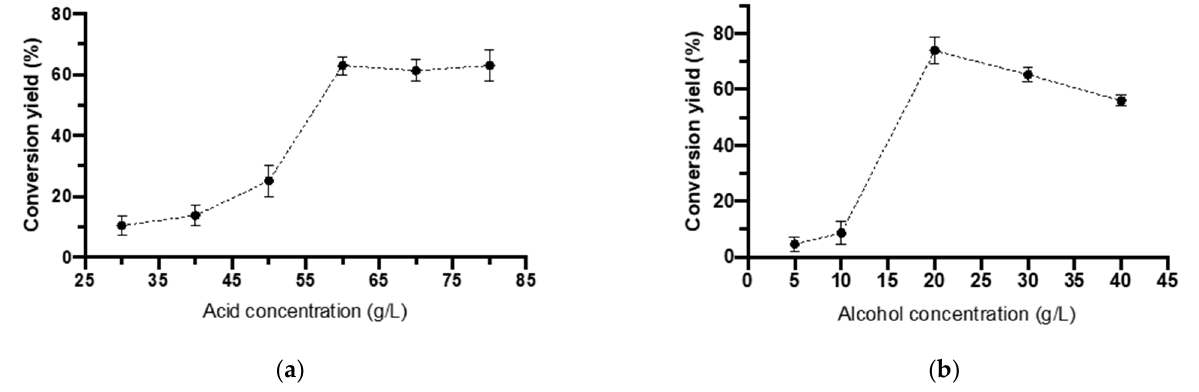
Figure 6. Effects of substrate concentrations on ester yield for PPL; ( a ) 30 g L − 1 constant sorbitol concentration; ( b ) 60 g L − 1 constant ibuprofen concentration; reaction conditions: PPL 10 g L − 1 , Cw = 10% v / v , 40 °C, 400 RPM, 24 h. All measurements were performed in triplicate.